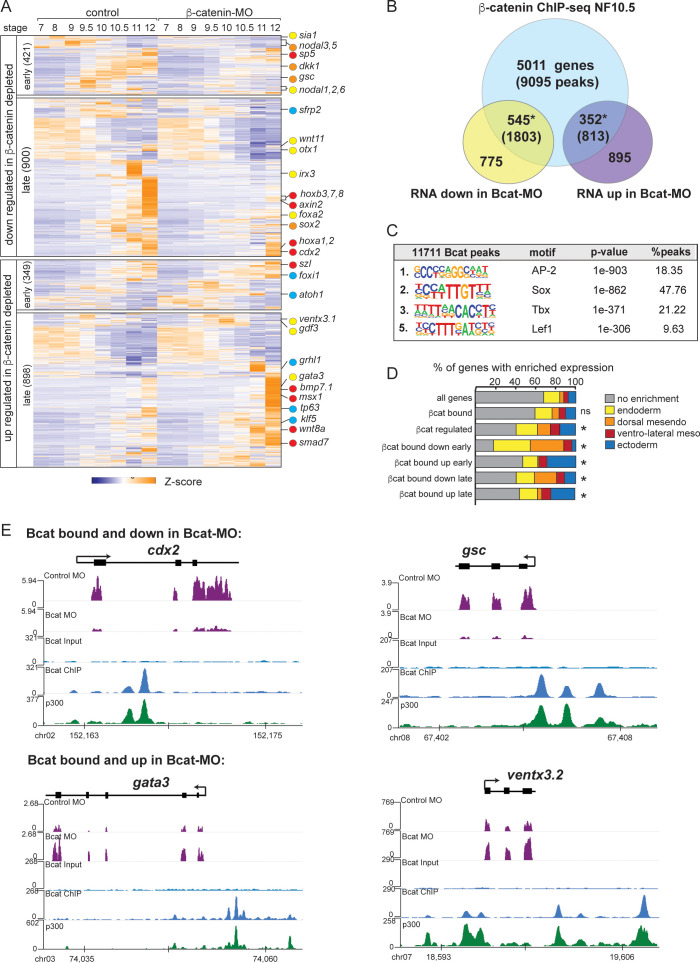
The Bcat-regulated genomic program.(A) Time course heatmap of Bcat-regulated transcripts. Differential expressed genes from a pairwise comparison of control-MO and Bcat-MO embryos (>2 FC, FDR < 5%) at each stage identified 2568 Bcat-regulated transcripts; 1321 downregulated and 1247 upregulated in Bcat-MO embryos. Key genes are color coded based on regional expression from (D). (B) Venn diagram intersecting Bcat-regulated genes with Bcat-bound genes (and associated peaks) from published X. tropicalis gastrula Bcat ChIP-seq data (Nakamura et al., 2016) identified 898 putative direct targets associated with 2616 peaks. Statistically significant intersections based on hypergeometric tests* p<0.001.* (C) Motif enrichment analysis of Bcat peaks by HOMER hypergeometric test. (D) Stacked bar graphs showing different patterns of enriched spatial expression based on RNA-seq of dissected gastrula tissues (Blitz et al., 2017). Distribution of expression patterns statistically different from all genes in the genome was determined by twosided Kolmogorov-Smirnov tests *p<0.01. (E) Genome browser views of representative genes showing the RNA-seq expression in control-MO and Bcat-MO embryos and Bcat and Ep300 ChIPseq tracks.